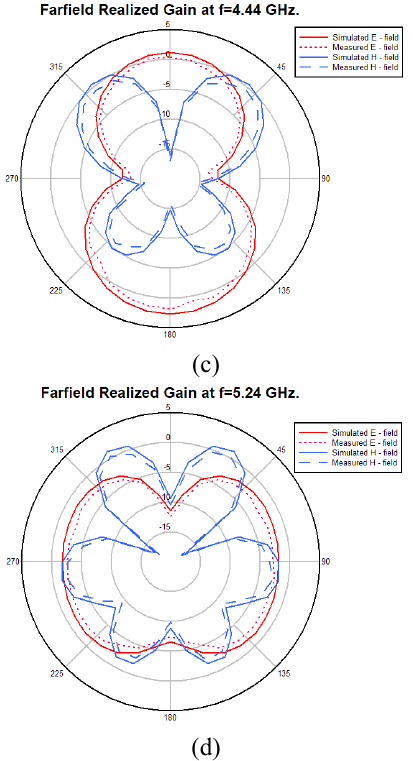
Figure 9: The simulated and measured radiation patterns in the polar at: (a) 1.65 GHz, (b) 3.14 GHz, (c) 4.44 GHz and (d) 5.24 GHz.